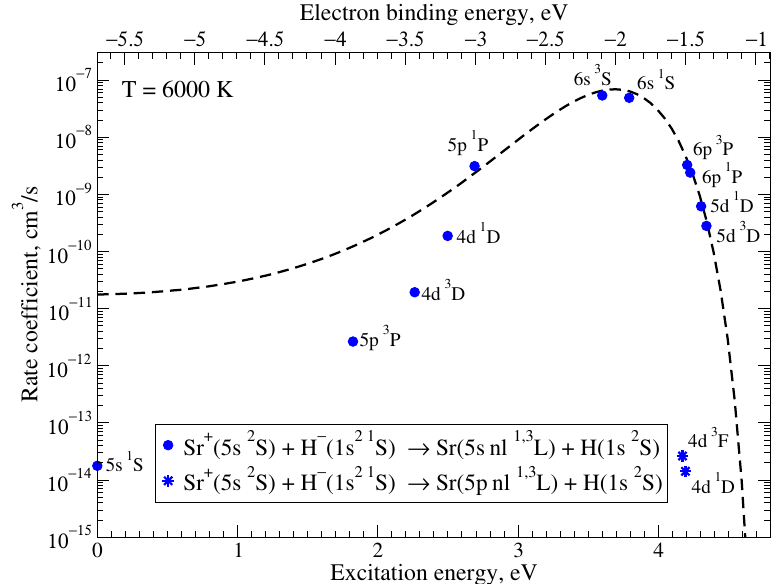
Figure 4. The rate coefficients (in cm 3 /s) at T = 6000 K for the mutual neutralization processes in (cid:0) (cid:1) + Sr + 5 s 2 S H − ( 1 s 2 1 S ) collisions. Filled circles correspond to the processes due to one-electron transitions; stars, to two-electron transitions; dashed line shows the general dependence of the rate coefficient according to the simplified quantum model